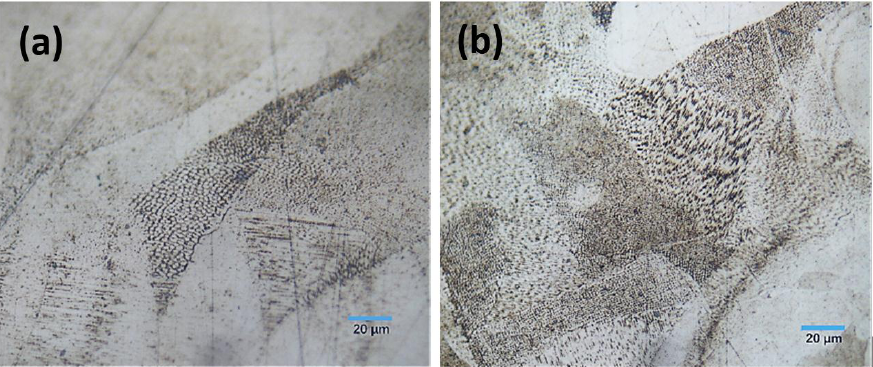
Figure 3. ( a ) and ( b ) show fine cellular-dendritic microstructures in SLM-fabricated 316L SS specimens.